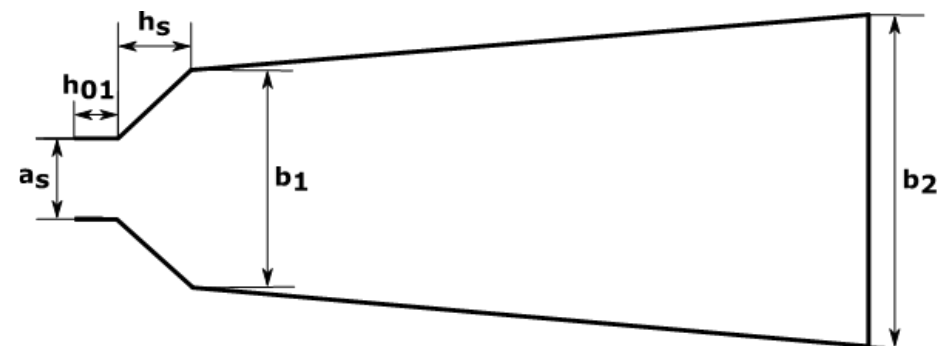
Figure 2. Main stator slot dimensions.